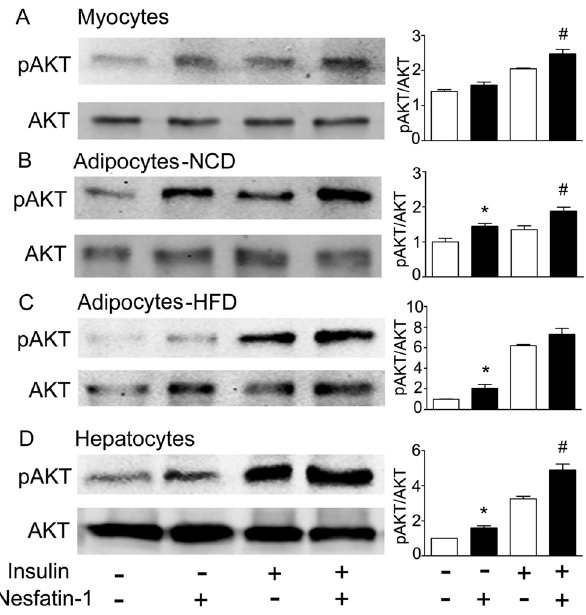
Figure 8. In vitro effects of nesfatin-1 on AKT phosphorylation. Cells were treated with nesfatin-1 (10 2 7 mol/L) for 30 min or/and insulin (10 2 9/ 2 10 mol/L) 10 min before harvest of cells. Phospho AKT (ser473) and AKT were detected by Western blotting using specific antibodies, in which AKT was used as internal controls. Shown are representative results of myotubes differentiated from primary myo- blasts (A), adipocytes from mice fed with NCD (B) or HFD (C) and hepatocytes (D). Levels of AKT phosphorylation are expressed as mean 6 SEM. * P , 0.05 vs. control, # P , 0.05 vs. insulin stimulation without nesfatin-1 treatment. Experiments were repeated more than three times for each condition.